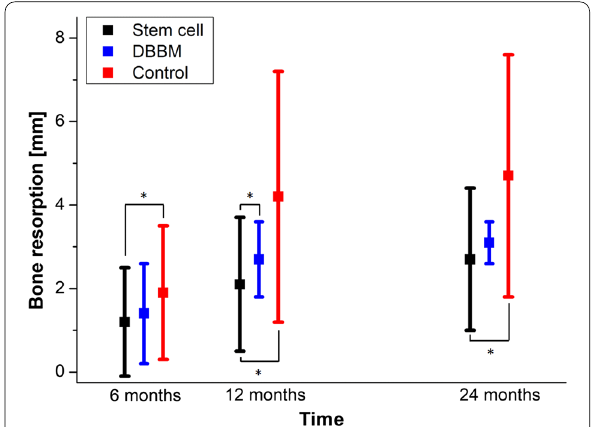
Fig. 6 Bone resorption after 6, 12 and 24 months in the three groups: stem cell group (black); DBBM group (blue); control group (red).